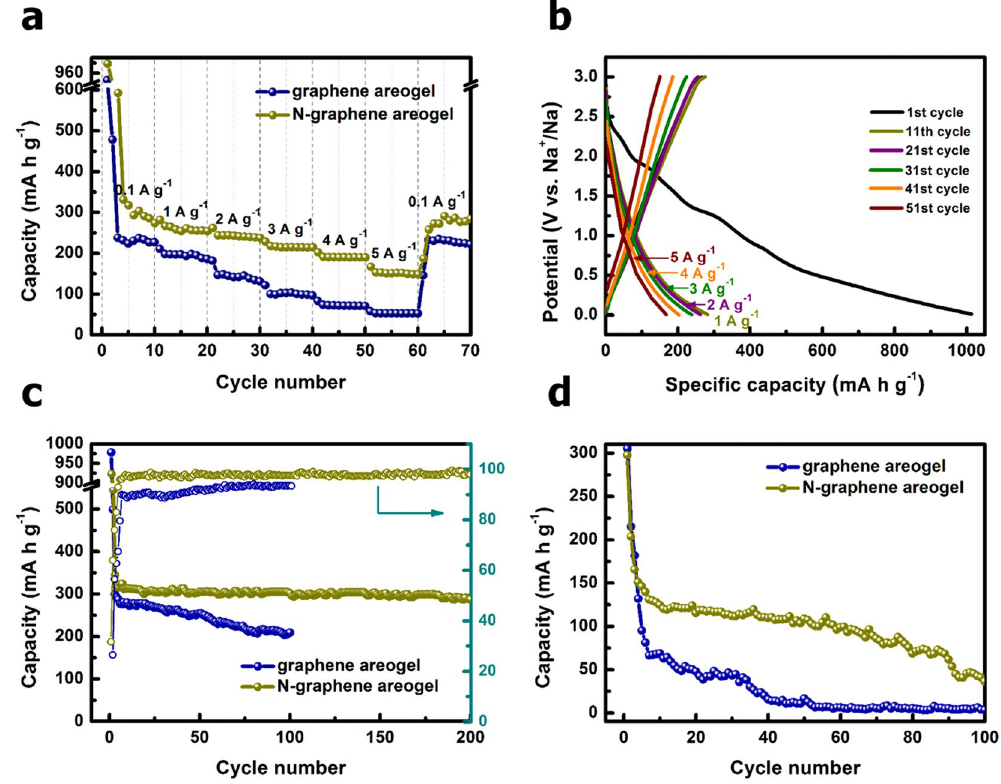
Figure 4. ( a ) Comparison of rate capability of the graphene aerogel and N-graphene aerogel at different current densities from 0.1–5 A g − 1 ; ( b ) galvanostatic charge/discharge profiles for the selected cycles of N-graphene aerogel at various current densities from 0.1–5 A g − 1 (corresponding to ( a )); comparison of cycling performance of graphene aerogel and N-doped graphene aerogel at a current density of ( c ) 0.1 A g − 1 and ( d ) 10 A g − 1 . Coulombic efficiencies of the graphene aerogel and N-graphene aerogel were inserted in Fig.